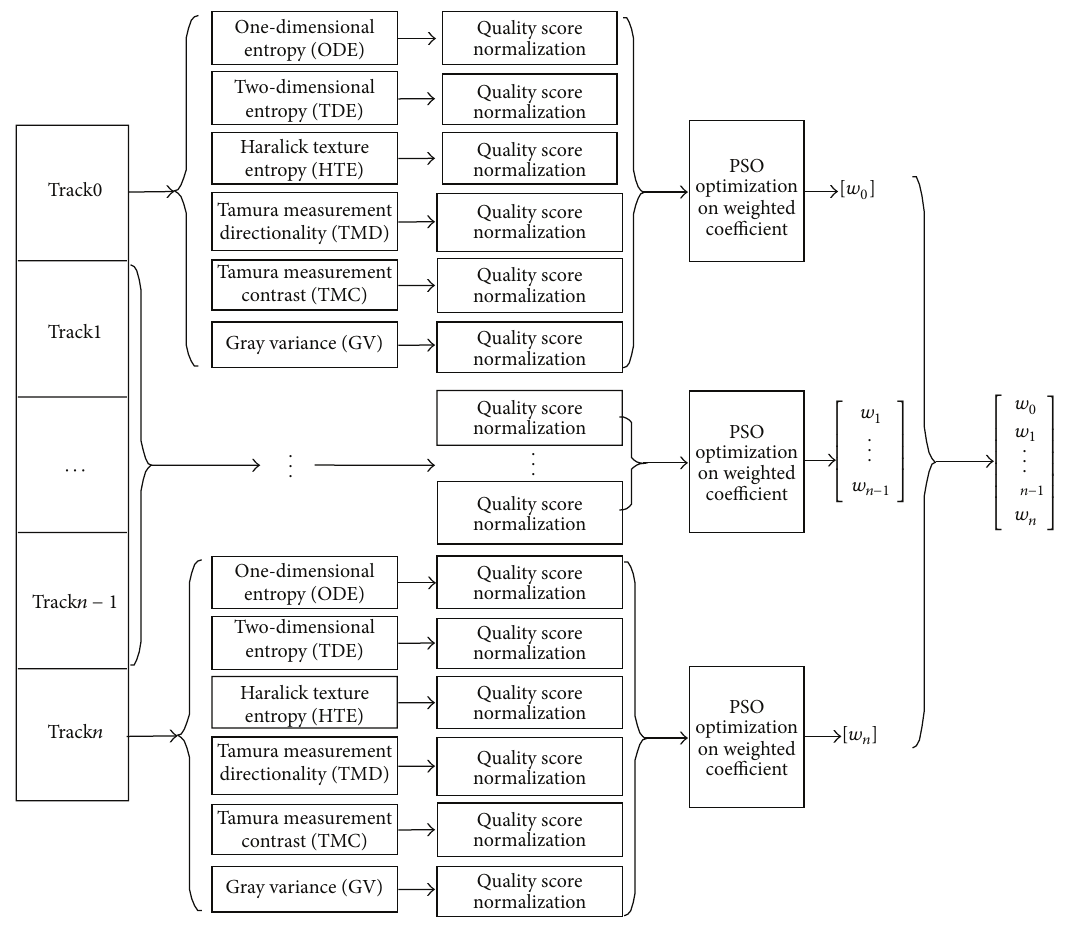
Figure 5: Quality evaluation block